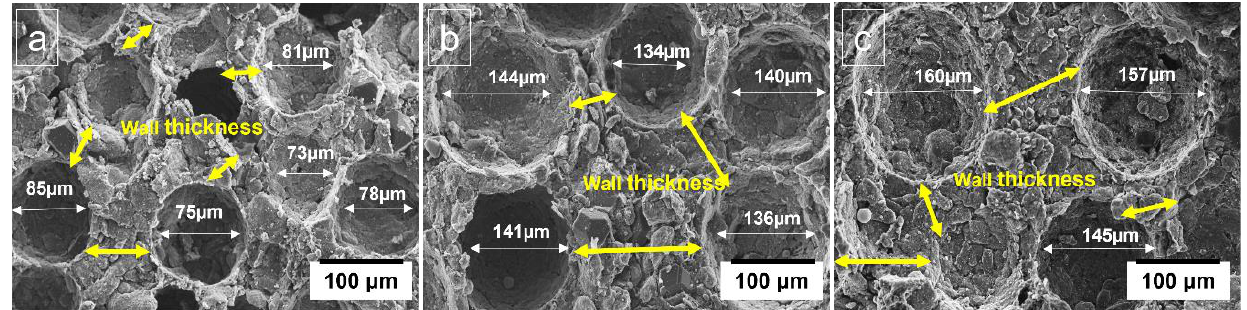
Figure 4. Pore size and wall thickness of pores in porous Al composites with varying PMMA particle size, ( a ) 75 µm, ( b ) 130 µm, and ( c ) 150 µm.